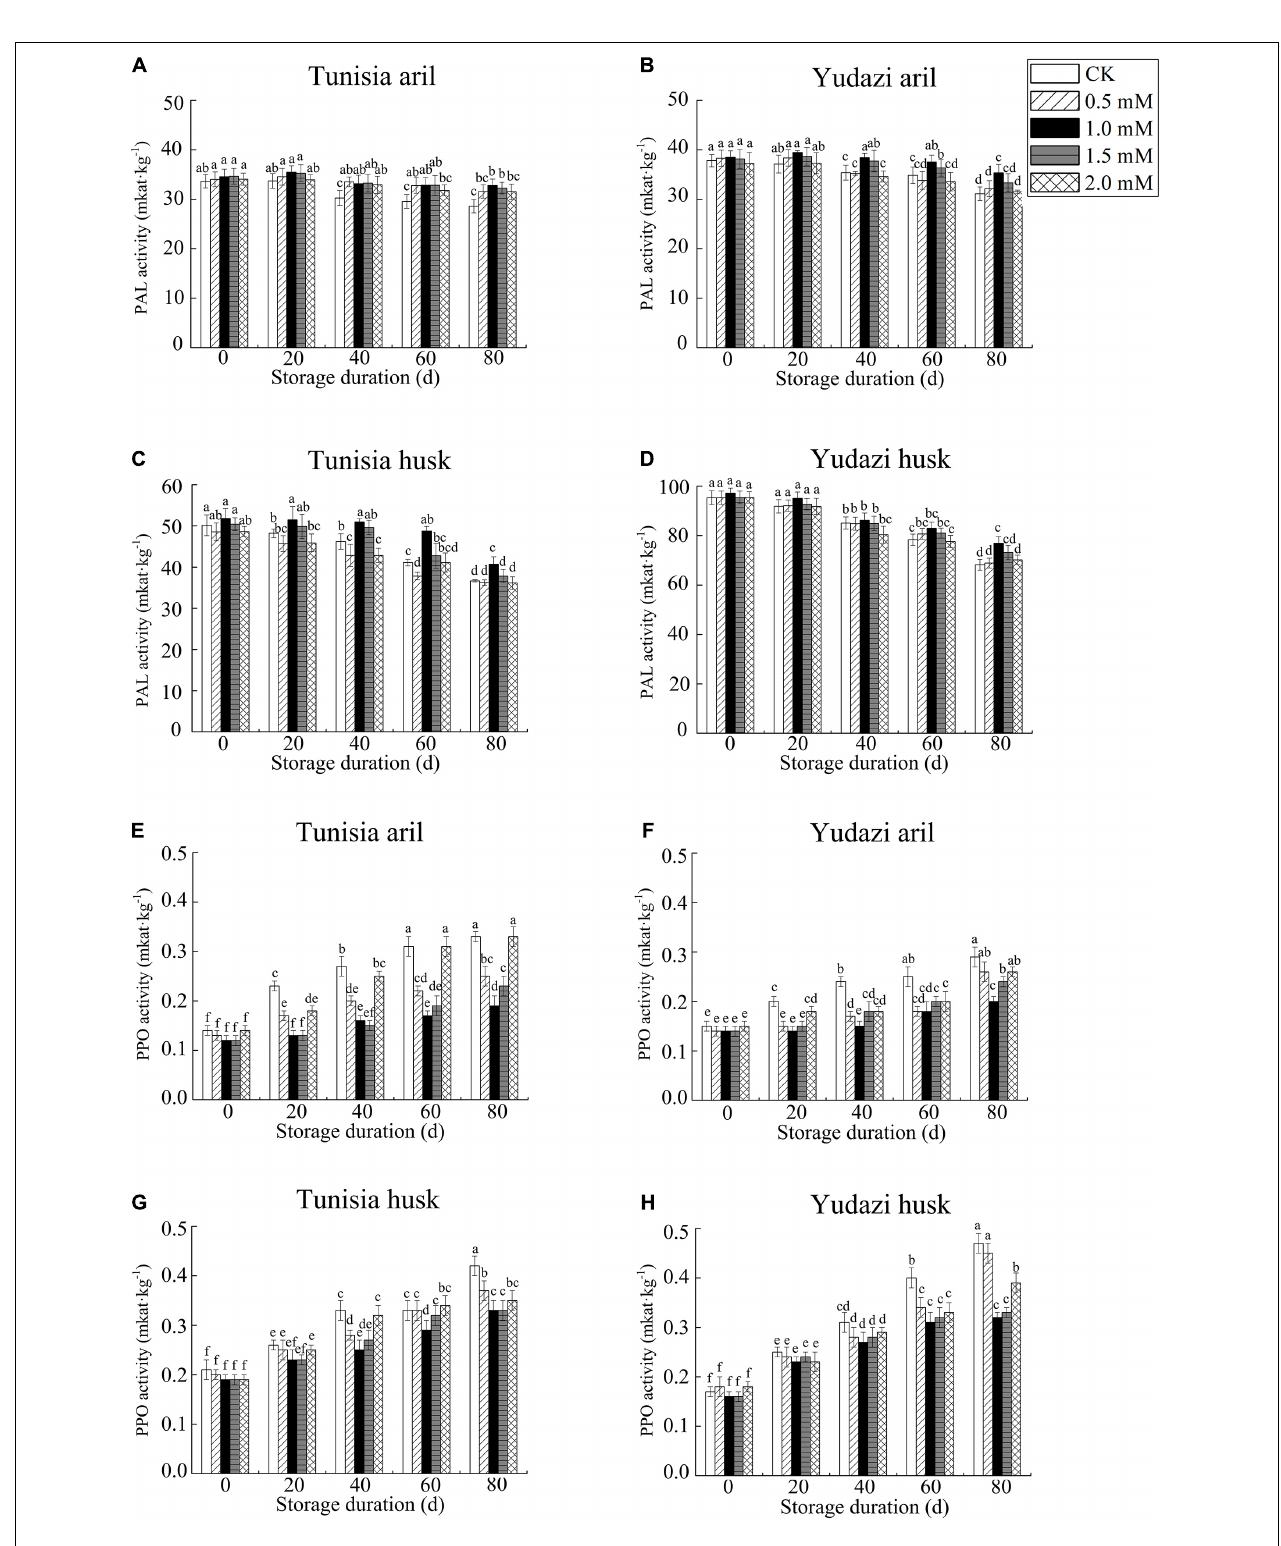
FIGURE 2 | Effect of arginine treatment on PAL activity and PPO activity in arils and husks from the two cultivars during cold storage at 4 ± 0.5 ◦ C. Panels (A,C,E,G) present Tunisia. Panels (B,D,F,H) present Yudazi. Different letters present significant differences among concentration treatments and sampling dates during the cold storage at P <